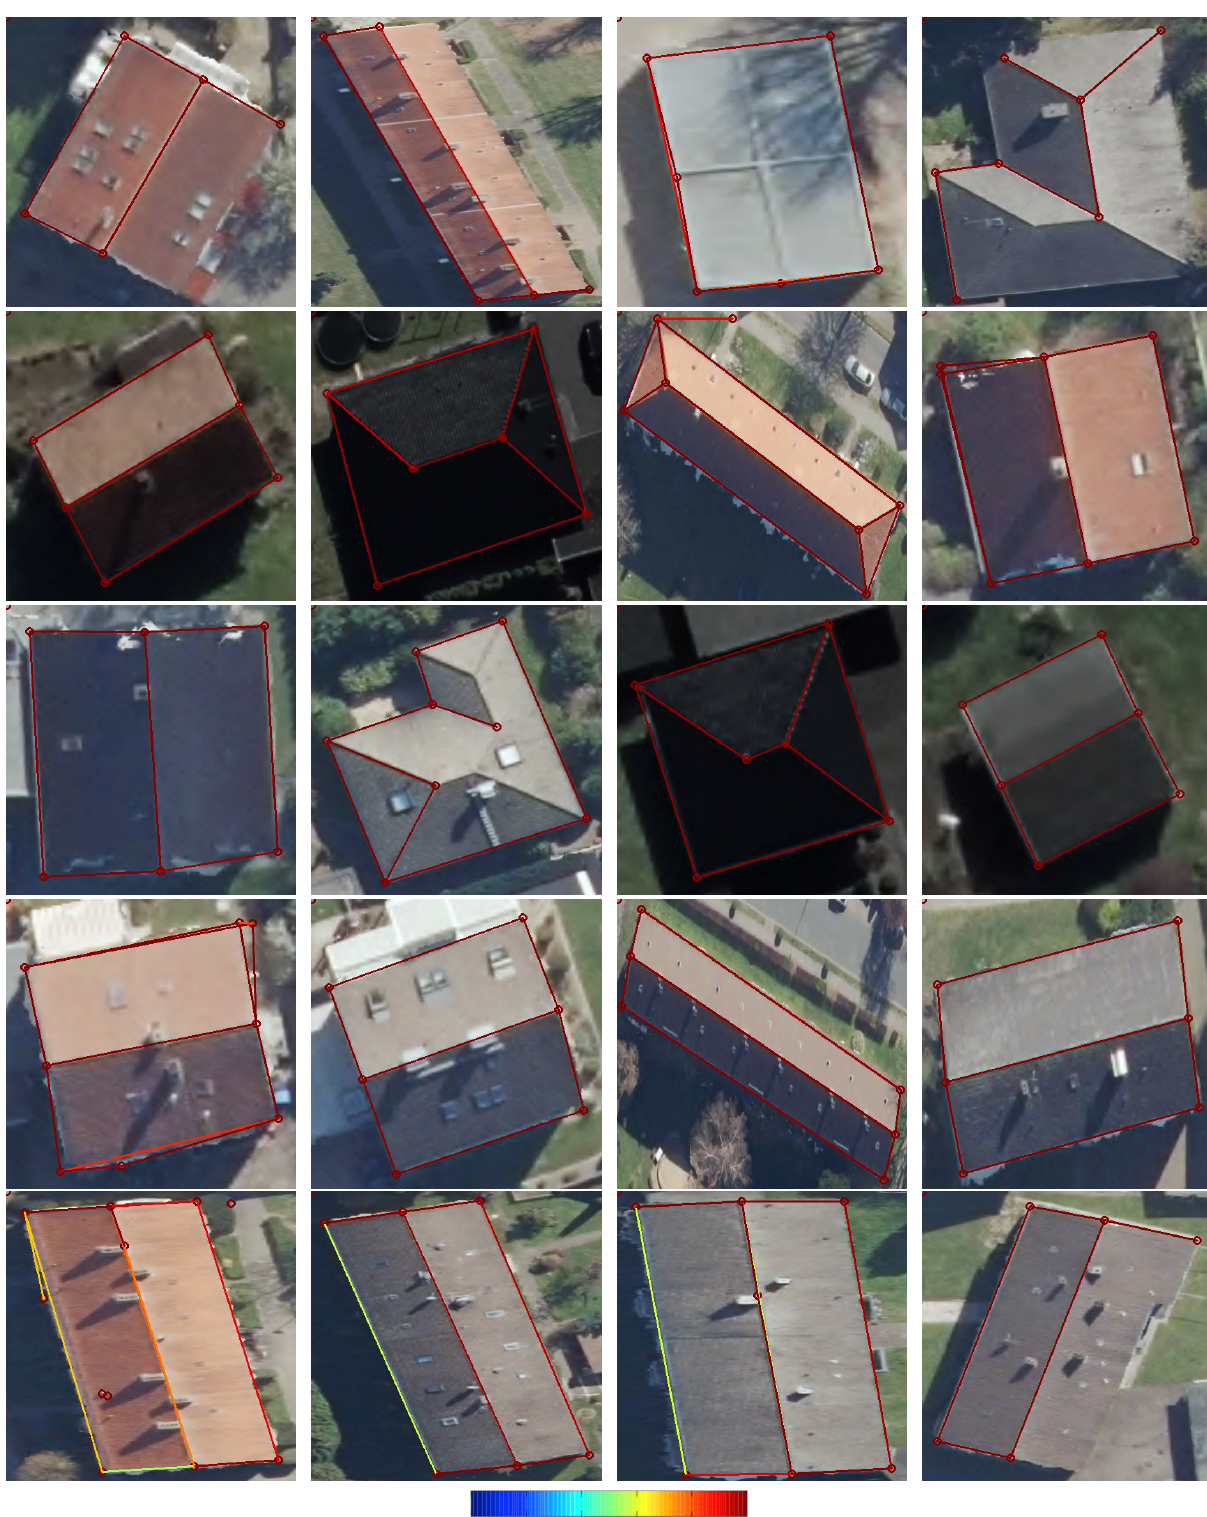
Figure 1. Results of case E6, see Table 1. The lines are colored according to the confidence value